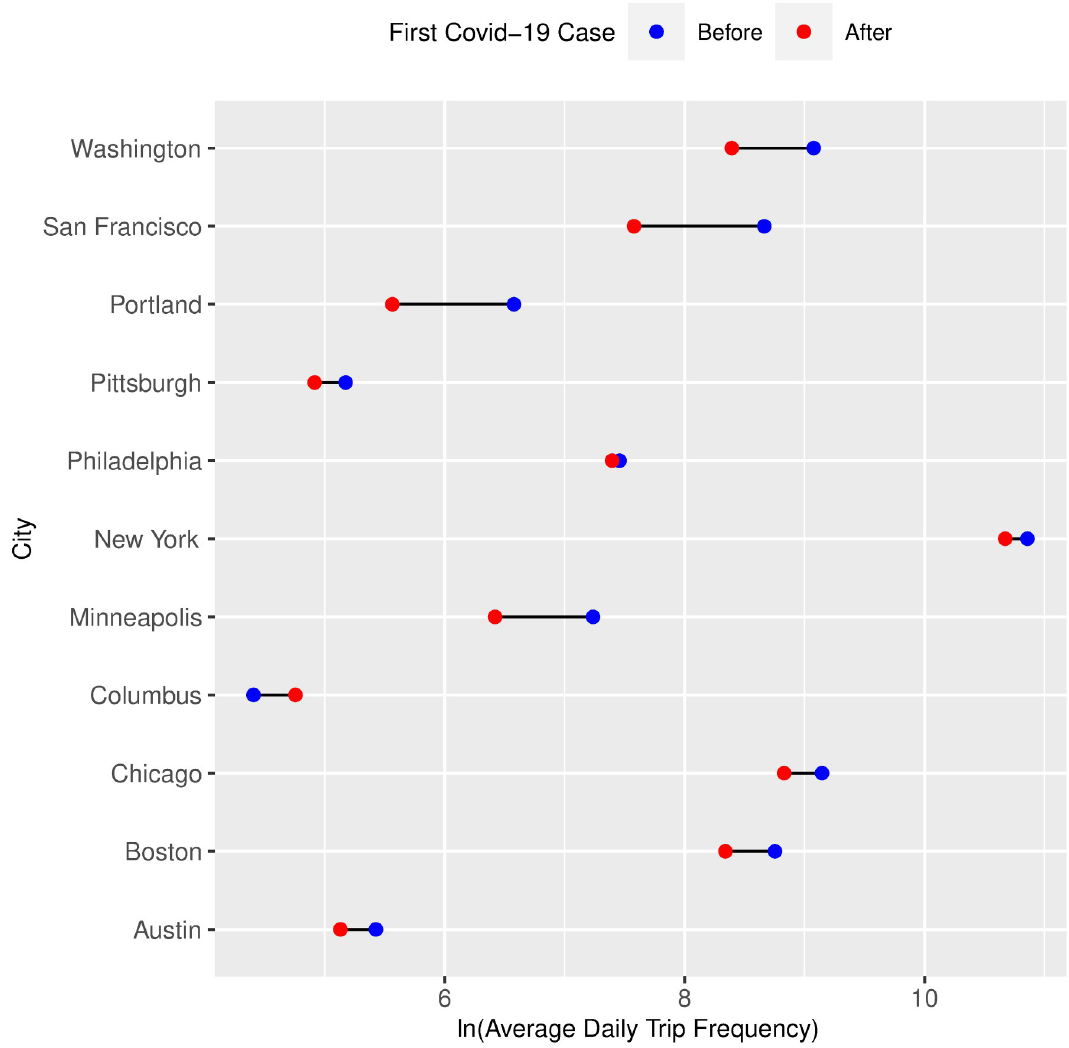
Fig 3. Dumbbell chart comparing the average daily bike-sharing trip frequency before and after the first Covid-19